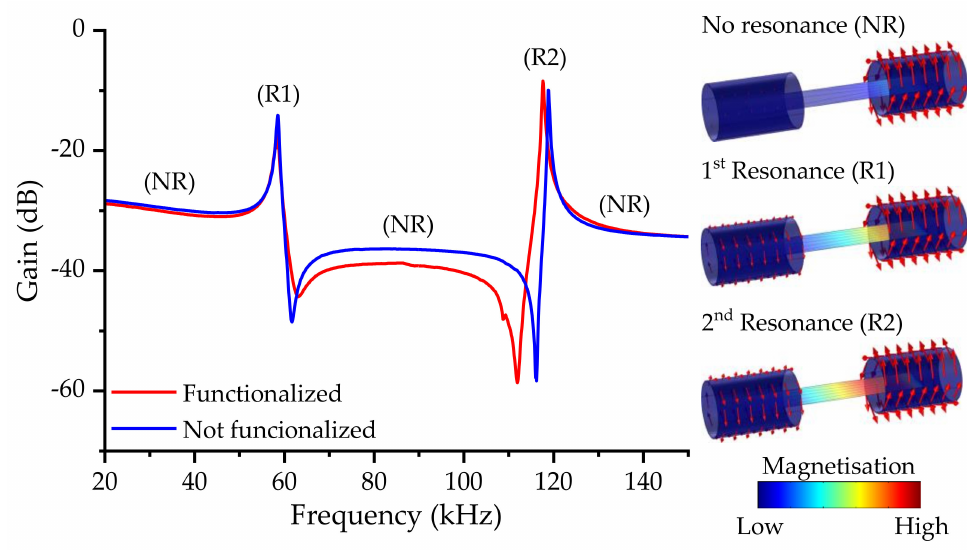
Figure 5. Frequency spectra of the transducer with and without the sensitive layer functionalization. Simulation results are used to illustrate the magnetoelastic resonance in the gain spectra for the no resonance state (NR) and the first (R1) and second (R2) harmonic of the magnetoelastic